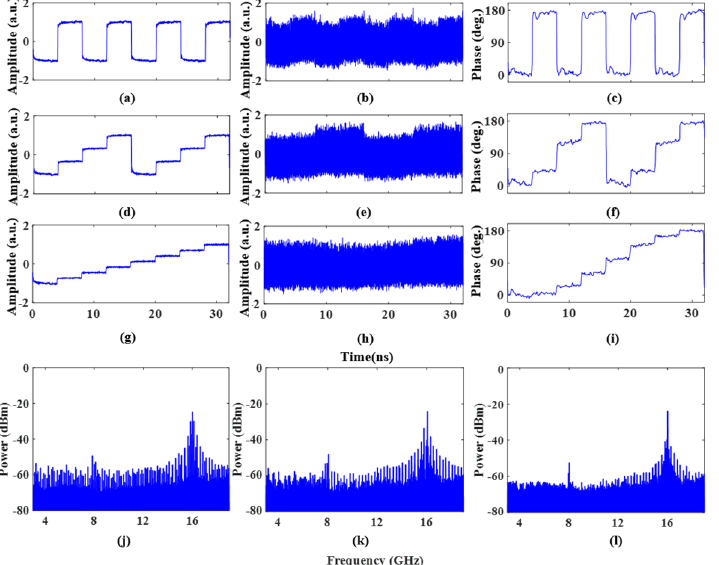
Figure 6. Waveform diagram of original coding signal: ( a ) binary, ( d ) quaternary, and ( g ) octonary; waveform diagram in doubled mode with a frequency of 16 GHz: ( b ) binary, ( e ) quaternary, and ( h ) octonary phase-coded signals; the corresponding phase information of ( c ) binary, ( f ) quaternary, and ( i ) octonary phase-coded signals; and the corresponding frequency spectrum of ( j ) binary, ( k ) quaternary, and ( l ) octonary phase-coded